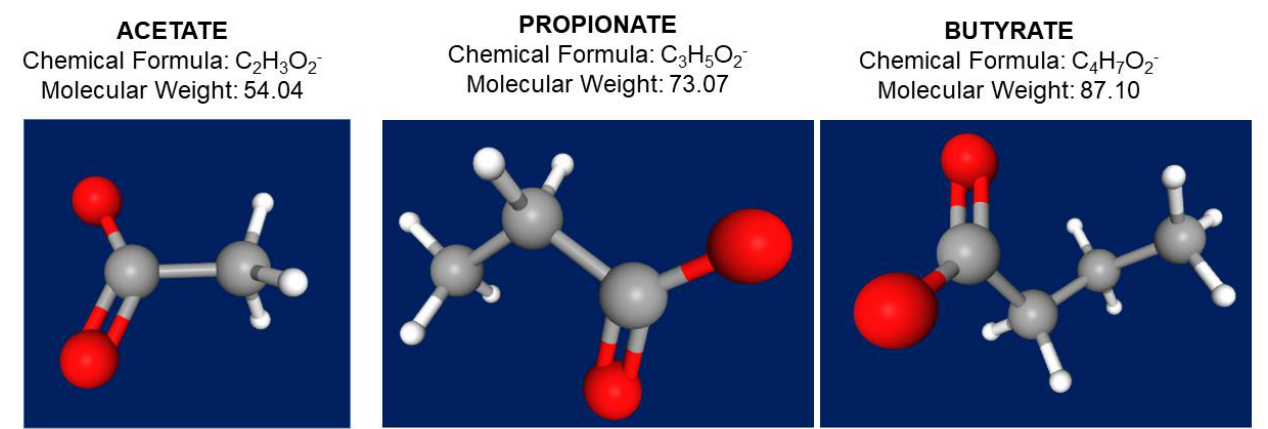
PEP—phosphoenolpyruvate; DHAP—dihydroxyacetone phosphate. Adapted from Kho et al. [31].